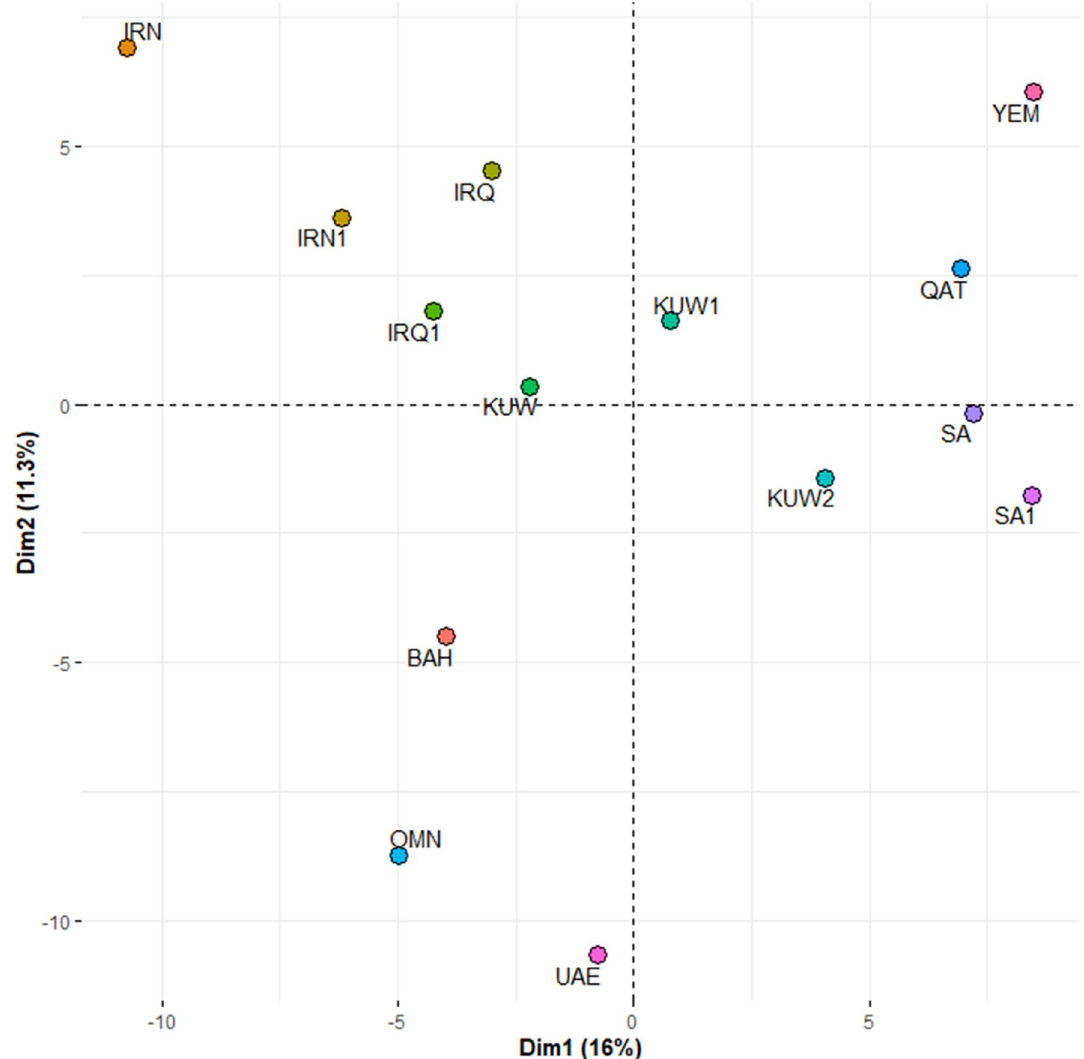
IRQ1), Iran (IRN and IRN1), Saudi Arabia (SA and SA1), United Arab Emirates (UAE), Oman (OMN), Yemen (YEM), and Bahrain (BAH) (generated using factoextra package 34 in R software 33